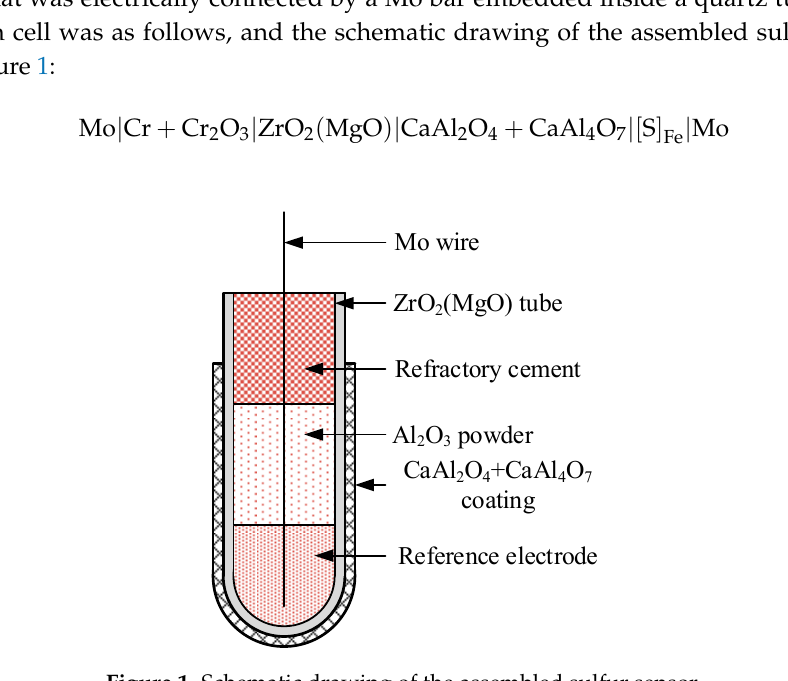
Table 1. Experimental process parameters of laser powder cladding (LPC).